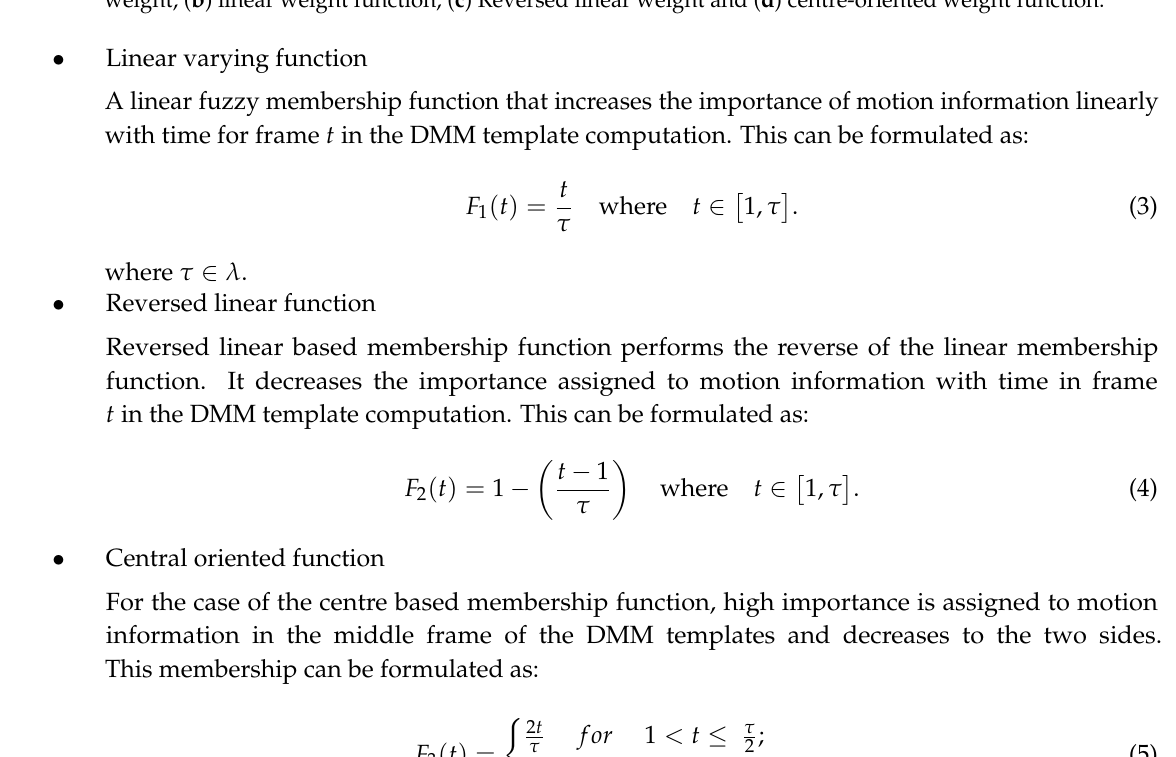
Figure 4. DMM xy based on different aspects of fuzzy weight functions: ( a ) Original DMM uniform weight, ( b ) linear weight function, ( c ) Reversed linear weight and ( d ) centre-oriented weight